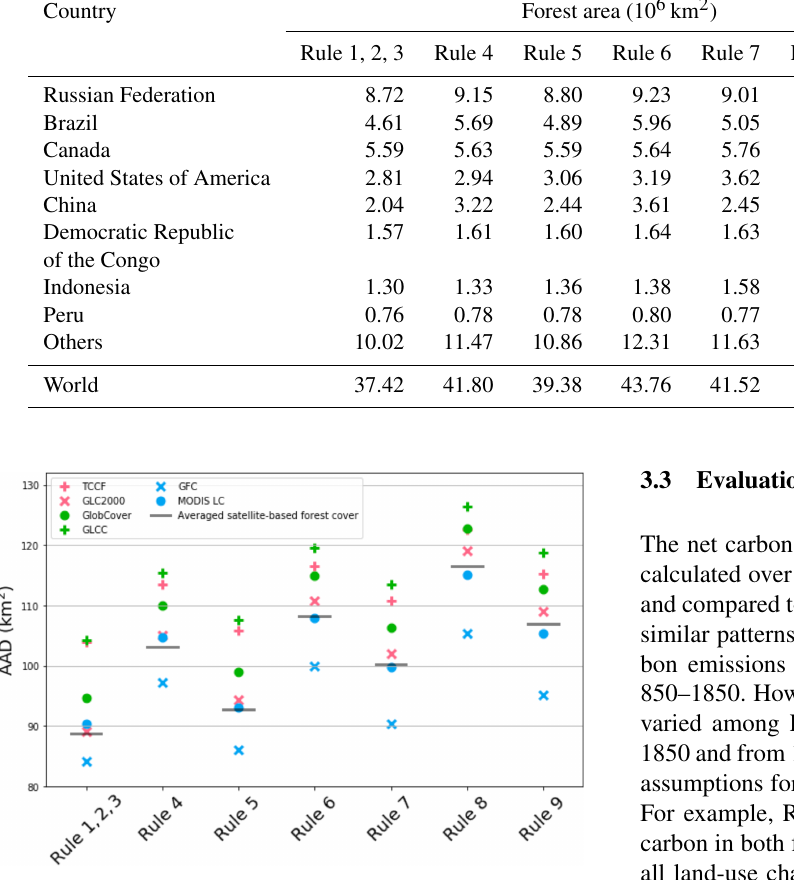
Figure 4. Global average of absolute difference in forest area be- tween maps estimated by translation rules and each of the six satellite-based forest cover maps as well as the averaged satellite- based forest cover